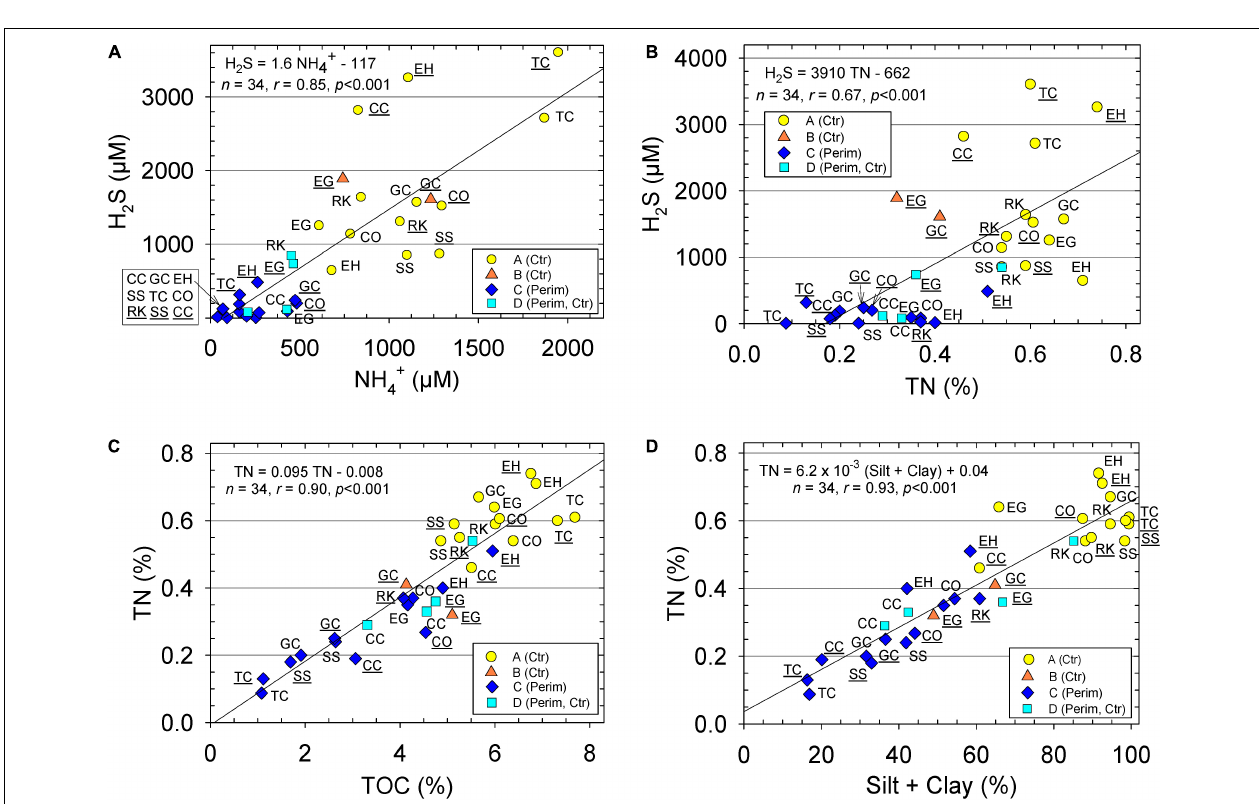
FIGURE 2 | Hierarchical cluster analysis created from range-standardized environmental characteristics and Euclidean distance. Four groups identified as shown by samples above red bars (A–D) . Samples from center (C) locations are highlighted, but not perimeter (P) samples. Sampling seasons represented by wet and dry.